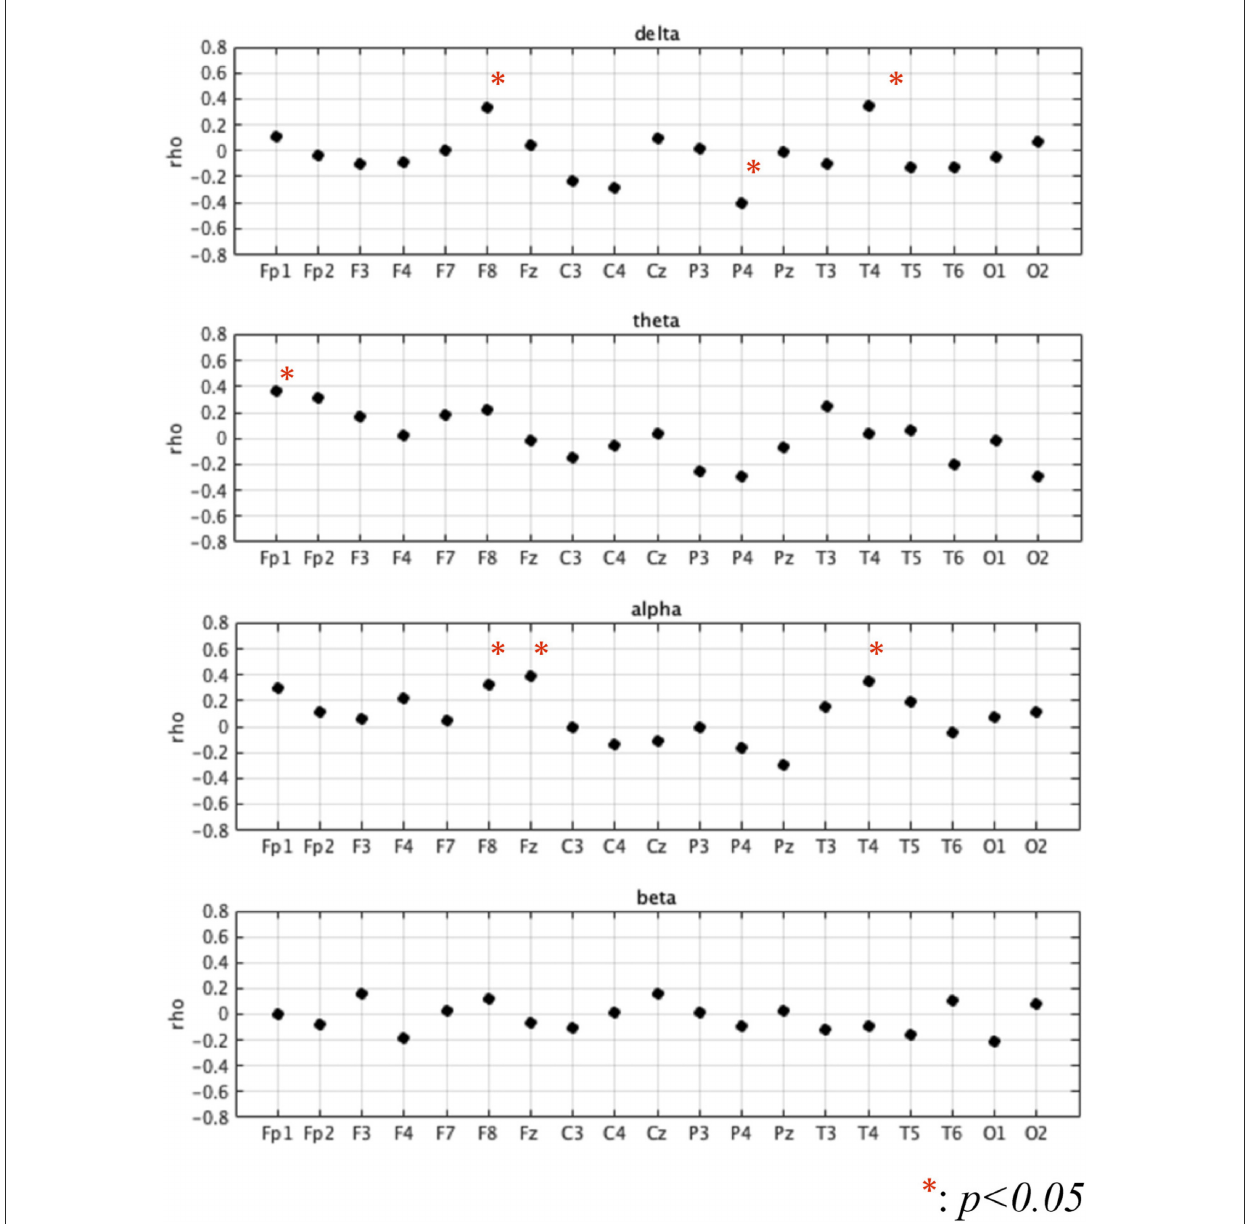
FIGURE1 Correlation coefficient (rho) between betweenness centrality (BC) values and Five Cognitive Functions test (Five-Cog) total score for each of 4 frequency bands (delta (2–4 Hz), theta (4–8 Hz), alpha (8–13 Hz), and beta (13–30 Hz)) and 19 electrodes. Statistically significant strong positive correlations were observed at F8 [rho = 0.335 ( p = 0.039)] and T4 [rho = 0.343 ( p = 0.034)] in the delta band, Fp1 [rho = 0.368 ( p = 0.022)] in the theta band, and F8 [rho = 0.325 ( p = 0.046)] and Fz [rho = 0.394 ( p = 0.014)] in the alpha band. In contrast, statistically significant strong negative correlation of the Five-Cog total score with P4 [rho = − 0.40 ( p = 0.012)] was observed in the delta